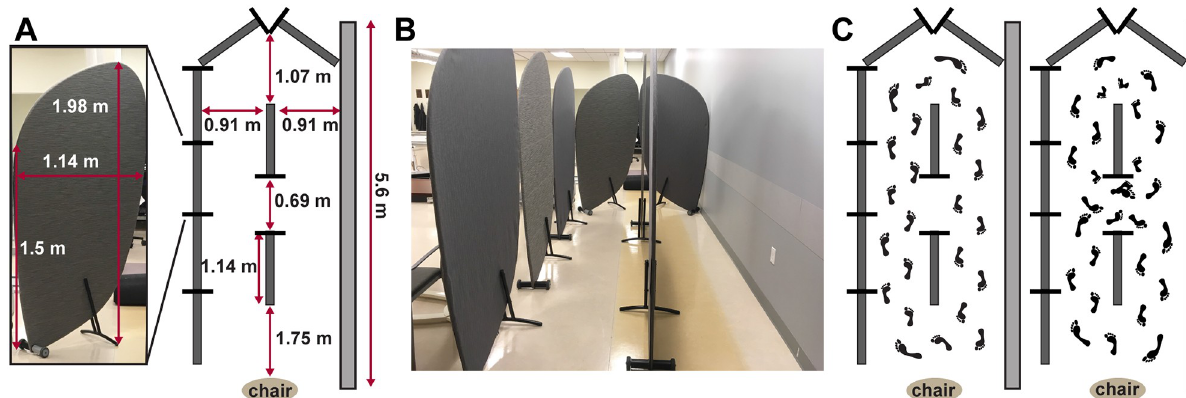
Fig 1. Turning and Barrier Course (TBC) dimensions and specifications. A : the individual barrier and course dimensions. Tall barriers limited vision around turns and narrow passageways to simulate a real-world environment. B : front view with patient walking in the TBC. C : aerial diagram of the TBC with barriers (dark grey bars) and wall (light grey bar). Subjects walked in two ellipses and then two figures of eight around the barriers; this task was repeated starting on both the left and right side, for a total of four ellipses and four figures of eight.